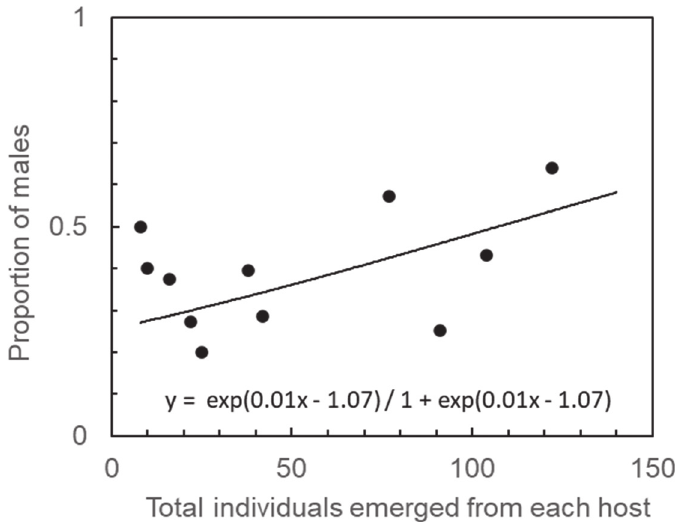
Figure 6. Sex ratios of emerged adults of Meteorus stellatus sp. nov. in relation to the number of individu- als per host